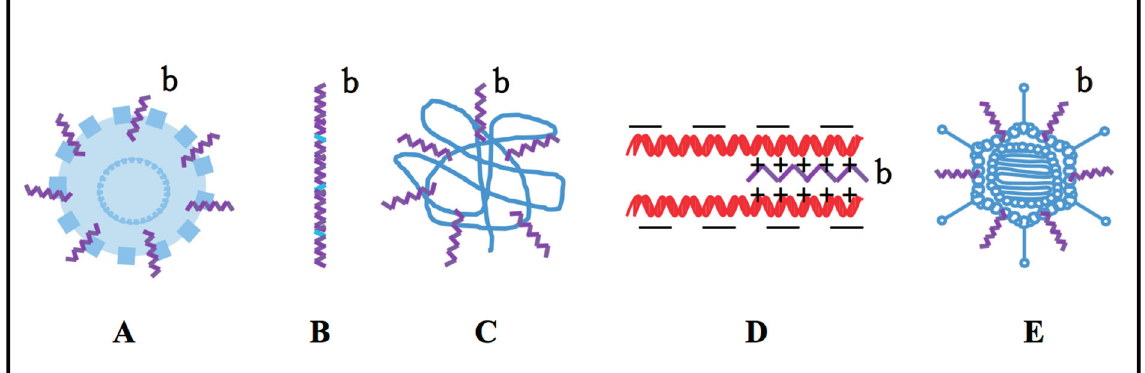
Figure 3. CPPs-based drug carriers. ( A ) Nanoparticles modified with CPPs; ( B ) poly